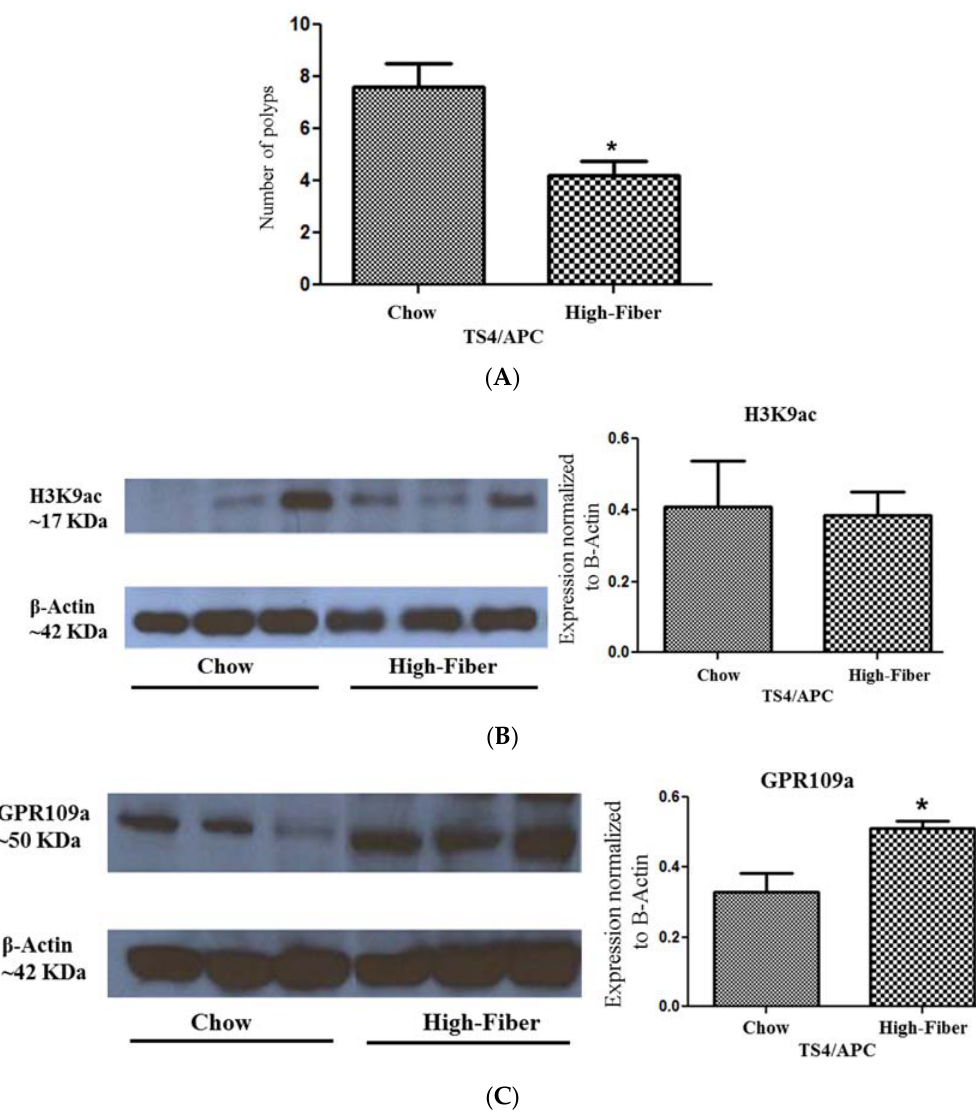
Figure 7 (A ‐ C). Effect of the high fiber diet on polyposis in TS4/APC mice ( n =5 per group): ( A ) Number of polyps was significantly reduced in high fiber ‐ fed mice compared to chow ‐ fed mice; ( B ) Left: Representative of histone acetylation blot, as assessed by H3K9ac antibody, on cecum tissue of high fiber ‐ fed and chow ‐ fed mice; Right: Western blot Expression of H3K9ac was normalized to the expression of Actin and was compared between the two groups; ( C ) Left: Representative of GPR109a blot using cecum tissue of high fiber ‐ fed and chow ‐ fed mice; Right: Western blot Expression of GPR109a, after normalization to Actin expression, increased by fiber treatment ( n =5 per group); asterisk represents p <0.05.